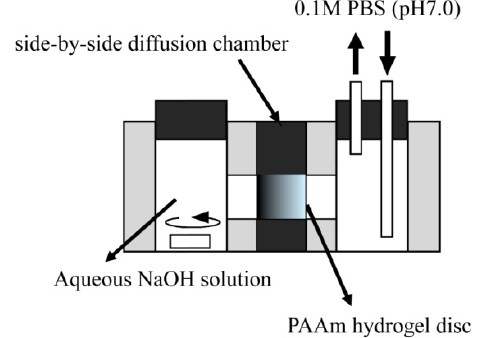
Figure 1. Schematic representation of a side-by-side diffusion chamber to generate a concentration gradient of carboxyl groups in PAAm